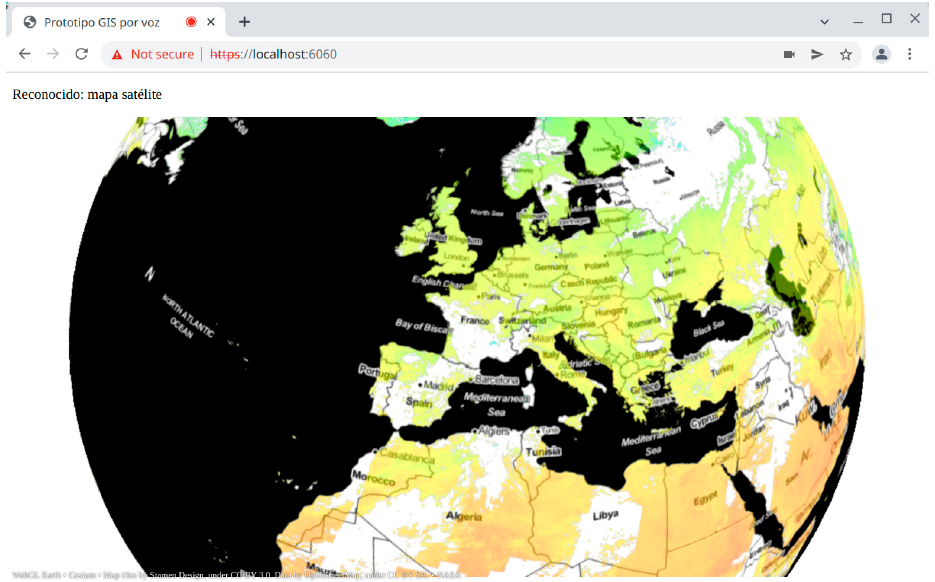
Figure 8. Prototype interface.